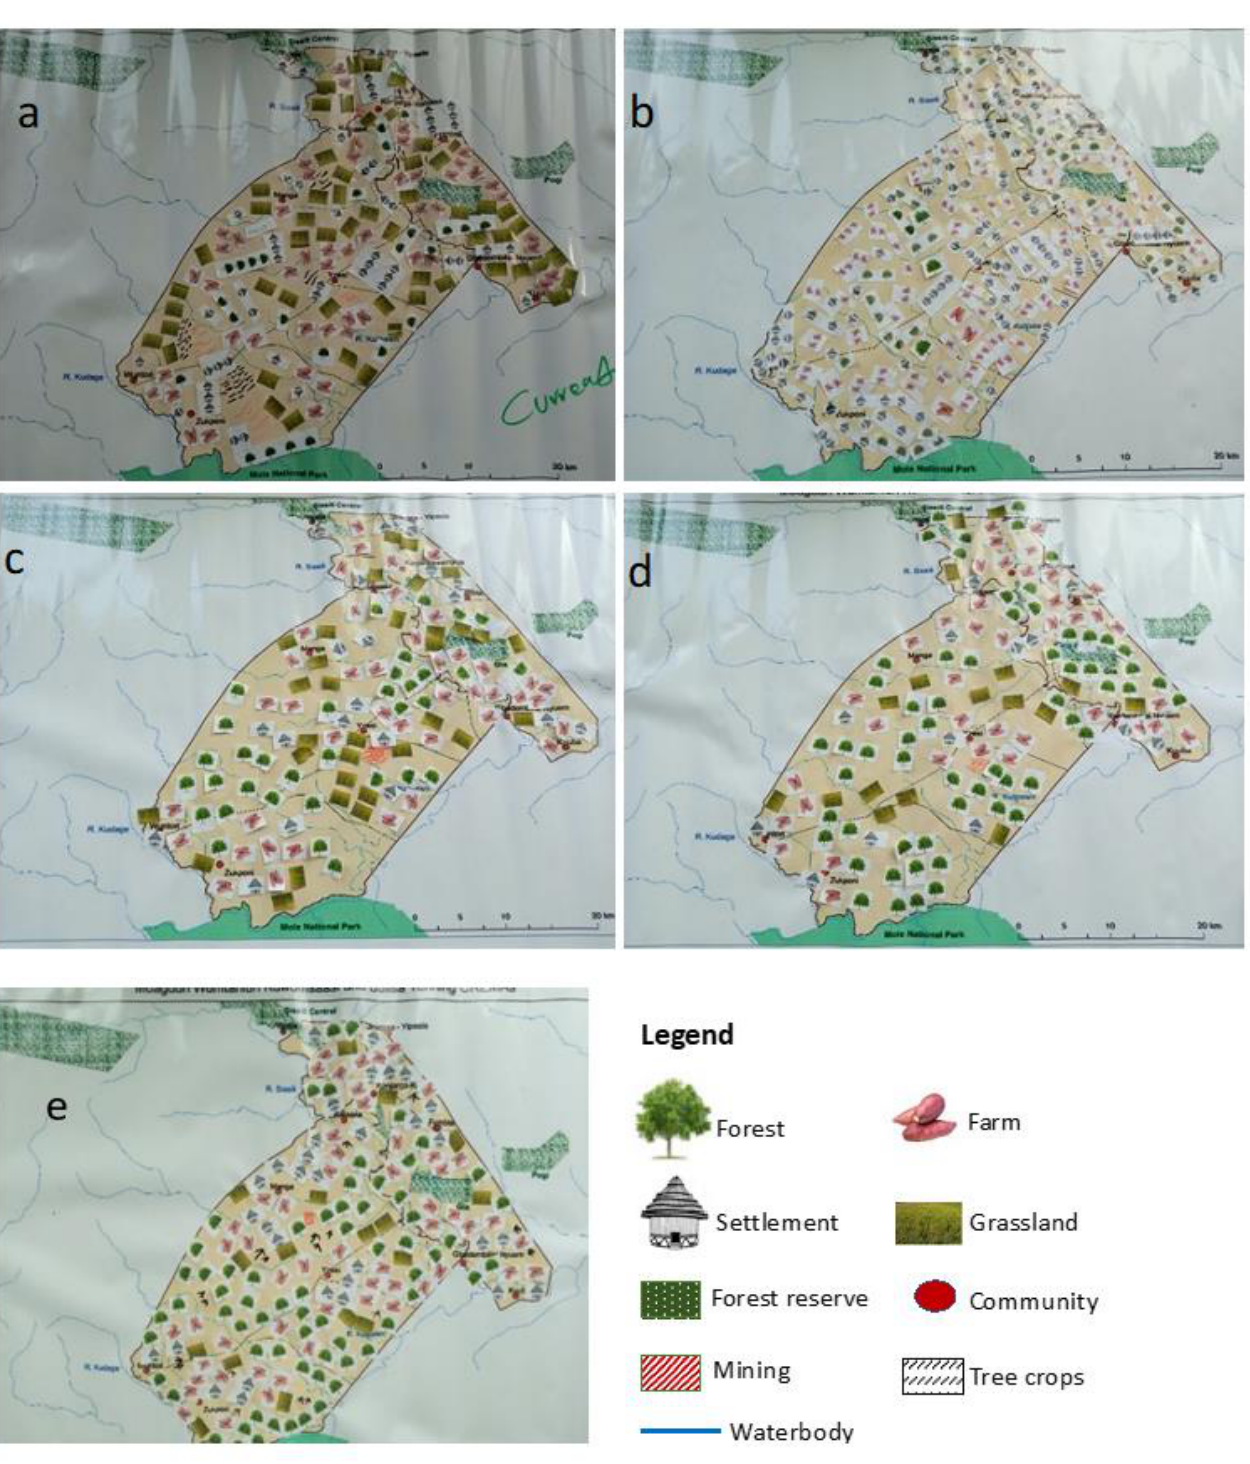
Figure 11. Participatory maps of current and desired futures of the BY-MWK landscape by community actors ( a = current; b = future), institutional actors ( c = current; d = future), and the consensus view of the future landscape ( e ).